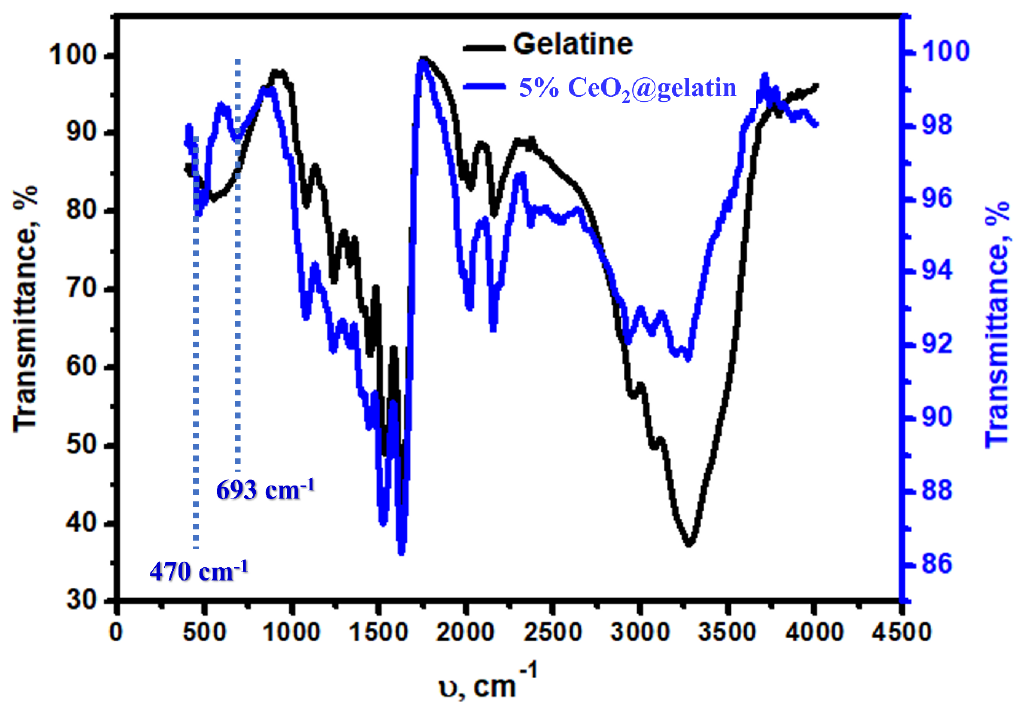
Figure 4. FT – IR analysis of gelatin and 5% CeO 2 @gelatin samples. Figure 4. FT–IR analysis of gelatin and 5% CeO 2 @gelatin